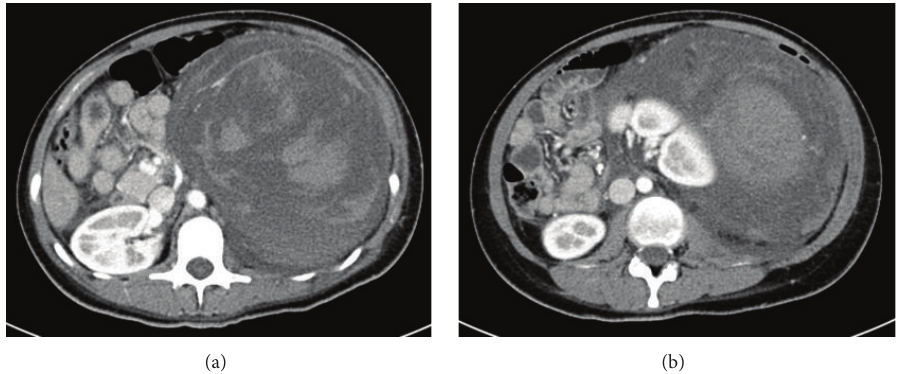
Figure 2: Transverse CT abdomen showing haematoma of varying ages and displaced left kidney.